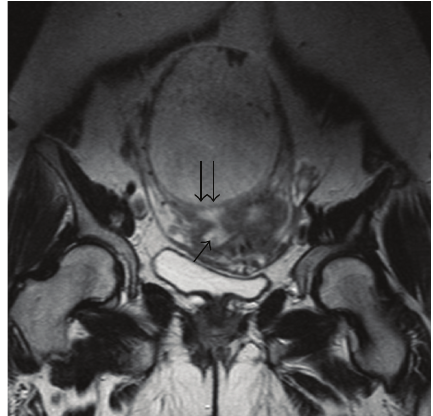
Figure 2: The wall of the gestational sac (double arrows) separates its contents from the uterine lumen